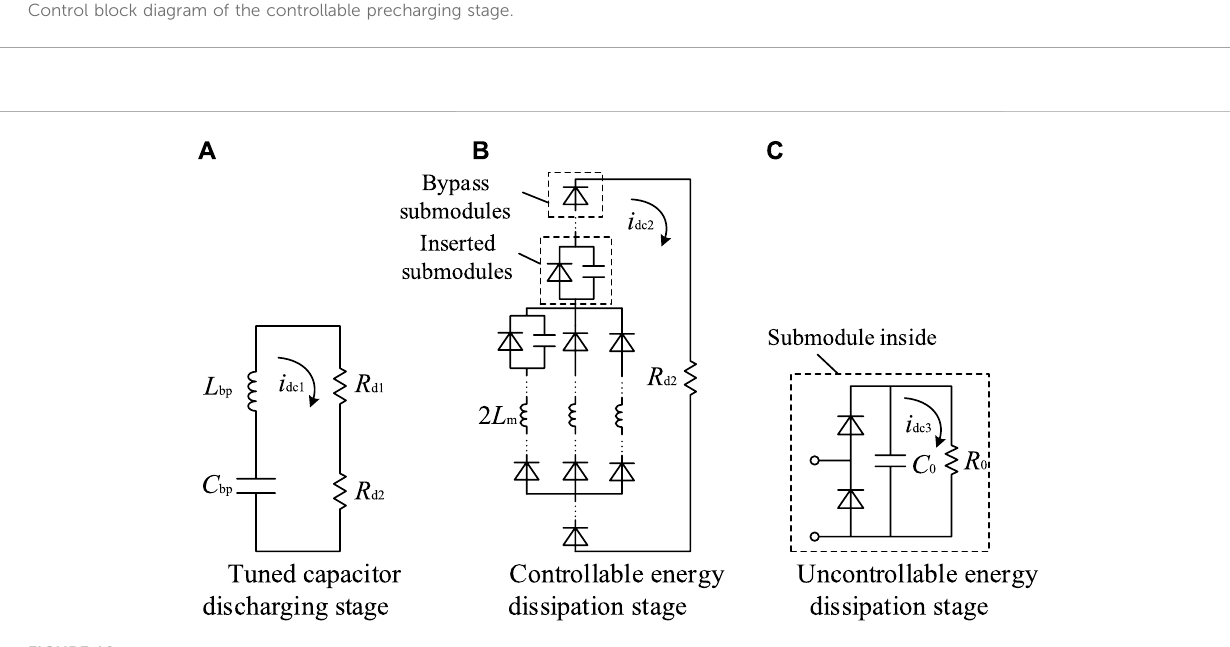
FIGURE 9 Control block diagram of the controllable precharging